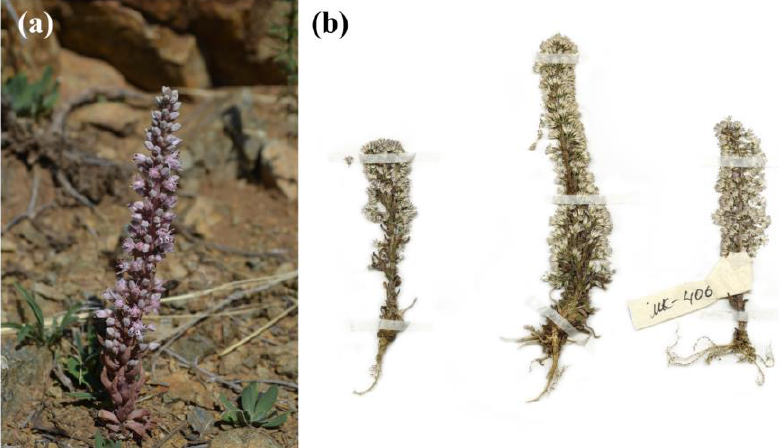
Figure 2. Mongolian herb Orostachys fimbriata (Turcz.) A. Berger. ( a ) and its samples ( b ).